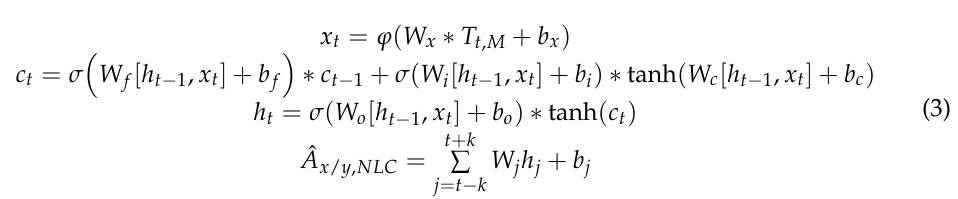
layer, forget gate fully connected layer, respectively. Furthermore, b is corresponding bias vectors, c , h represent the memory cell state and out- the output of the 1D-convolution layer, t t put state of BiLSTM layer.  is the LeakyRelu activation function and tanh is the hy- perbolic tangent activation function,  is the logistic sigmoid function. sents the nonlinear impairment estimated by CNN-BiLSTM neural network structure.